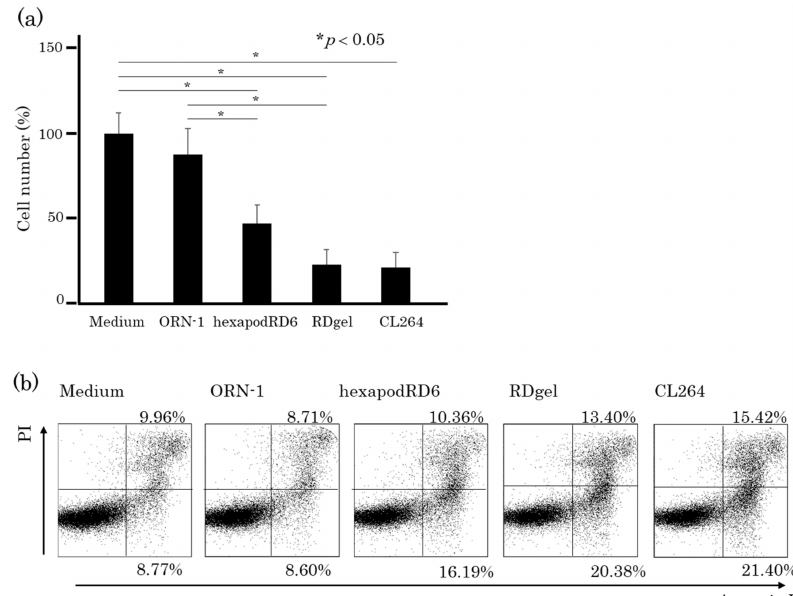
Figure 8. E ff ects of conditioned media of RAW264.7 cells on colon26 cancer cells. ( a ) Live colon26 cell counts after addition of conditioned medium. The conditioned medium was collected at 8 h after the addition of RNA / DNA. The results are expressed as mean ± SD of three independent experiments. ( b ) Apoptosis in colon26 cells after addition of conditioned medium. The proportion of colon26 cells stained with Alexa Fluor 488-labeled anti-annexin V antibody and propidium iodide (PI) was measured by flow